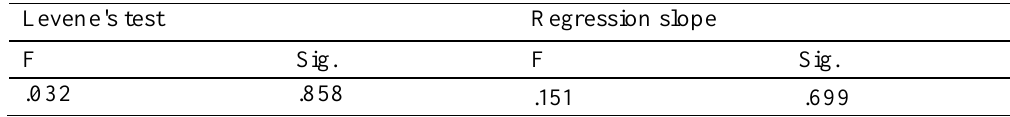
Test of Homogeneity for Achievement Test Scores of Both Groups Levene's test Regression